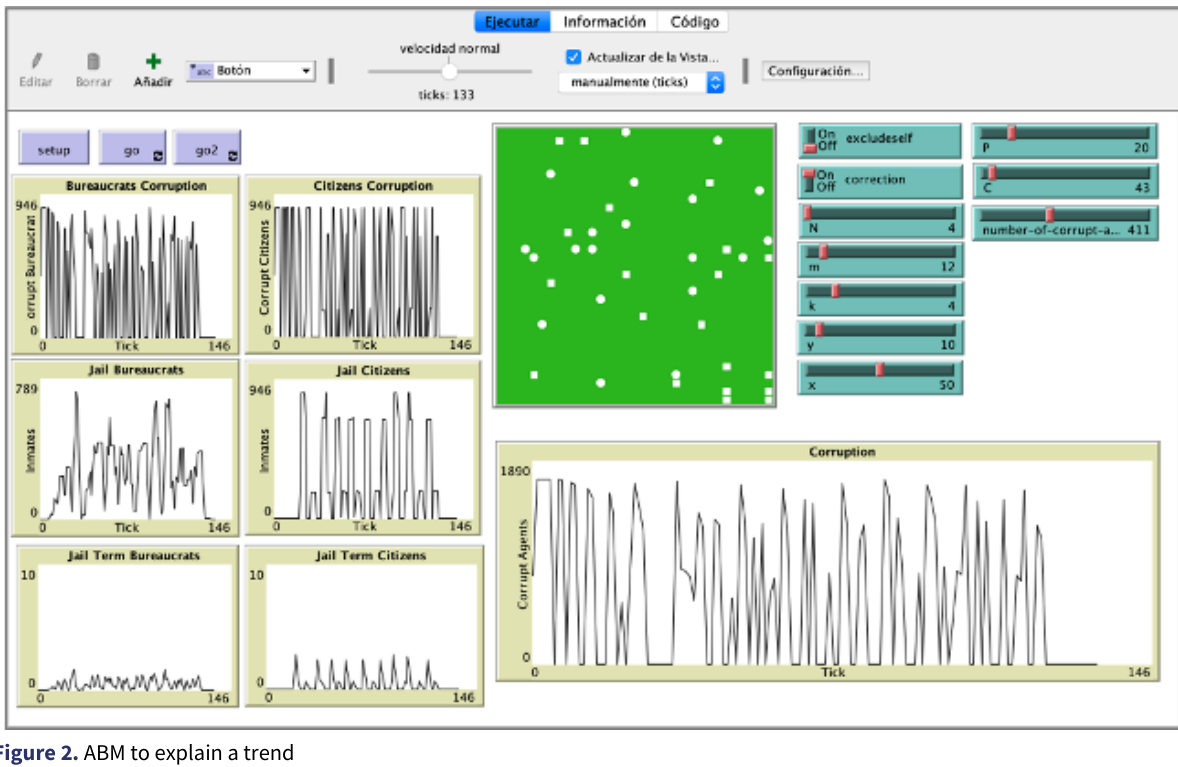
Figure 2. ABM to explain a trend Source Adapted from (Godet,